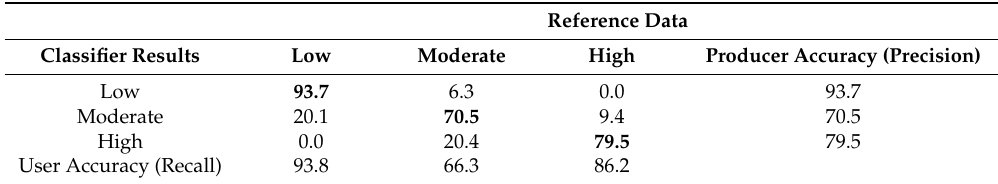
Table 6. Confusion matrix for the three burn severity classes (all values are presented as percentages from total). In bold is the percent (%) hit for each burn class category.